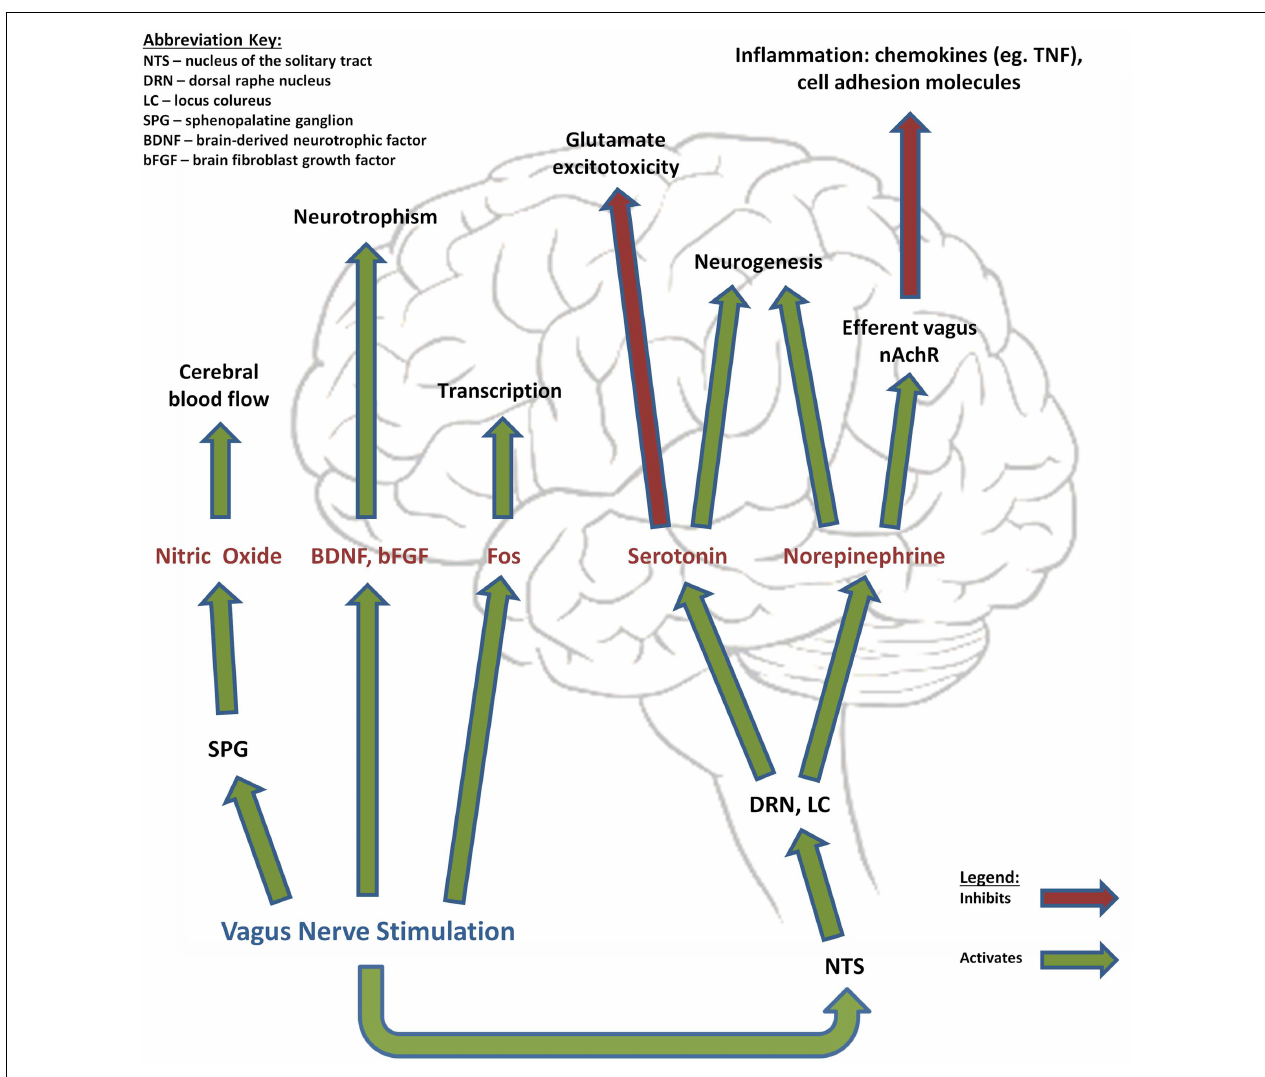
FIGURE 1 | Effects of vagus nerve stimulation .Vagus nerve stimulation has been shown to modulate the release of a variety of factors that regulate important mechanisms in stroke pathophysiology, such as cerebral blood flow, neurotrophism, neurogenesis, excitotoxicity, and